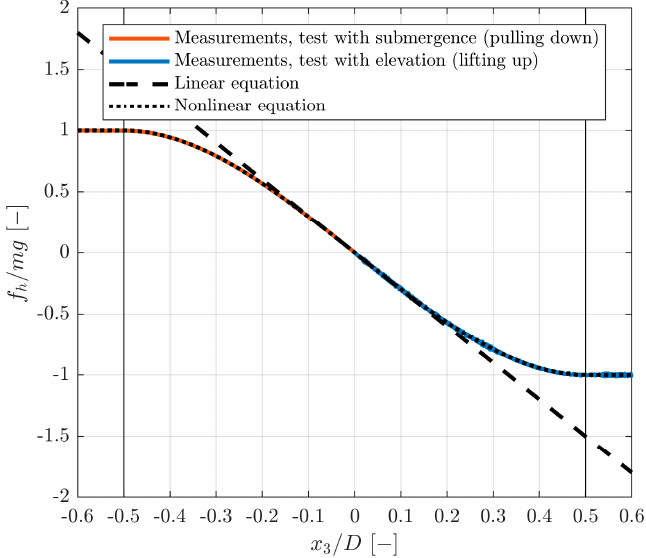
Figure A3. Measured hydrostatic forces as function of the draft. Nonlinear (Equation (A1)) and linear (Equation (A3)) analytical expressions of the hydrostatic force are included.